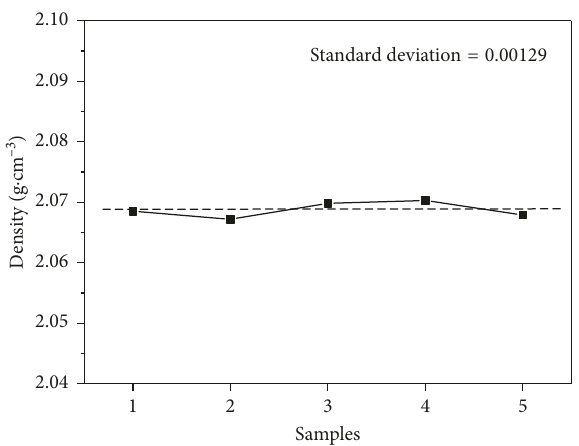
Figure 11: Densities of the molded parts of feedstock